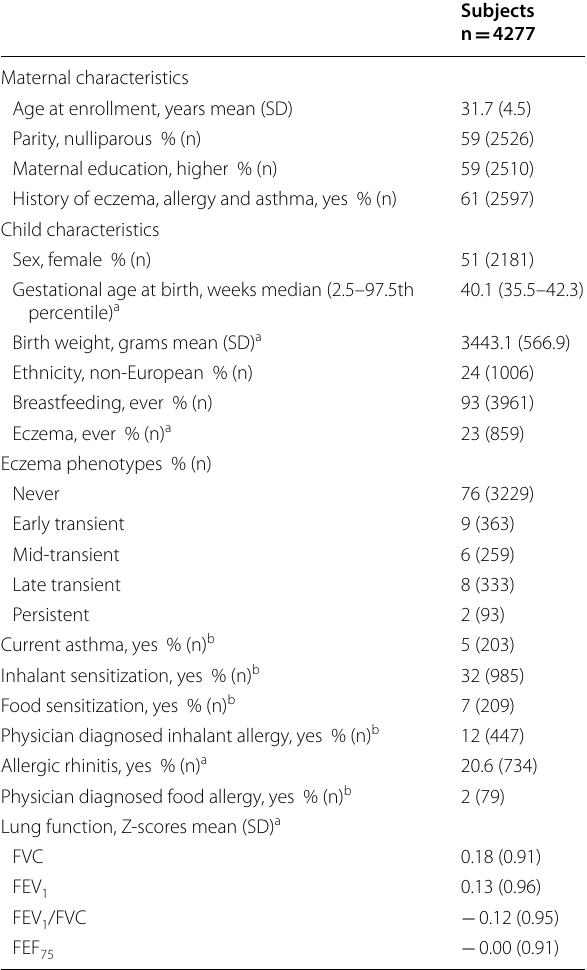
Table 1 Characteristics of children and their